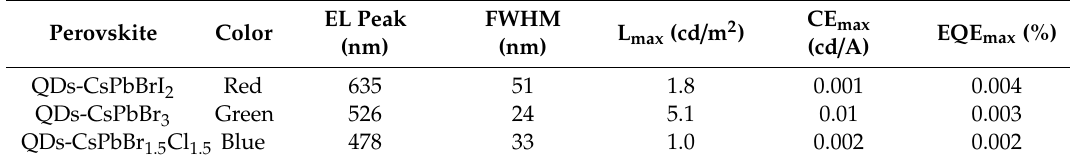
Table 1. Summary of perovskite QDs-CsPbX 3 LEDs